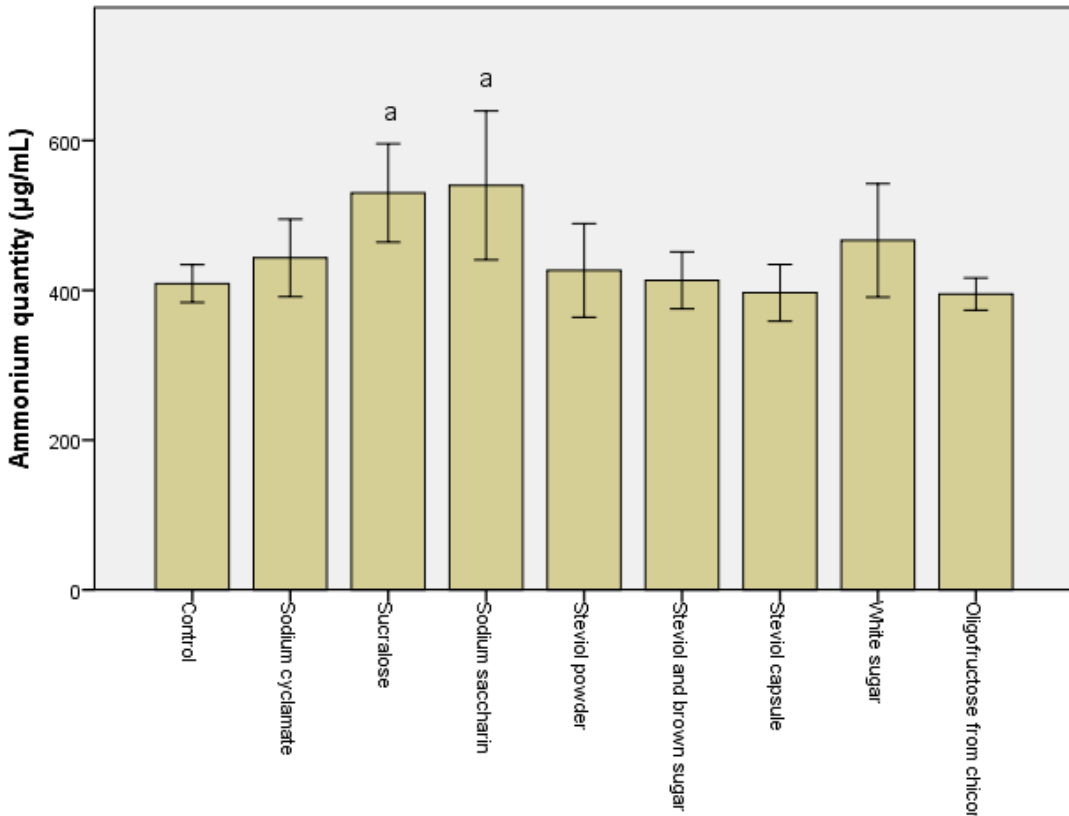
Figure 1. Quantity of ammonium ( µ g / mL) obtained after the in vitro tests through GIS1 as a measure of the impact of consuming sweeteners on the metabolic activity of the microbiota. Different letters indicate significant statistical differences (a: p ≤ 0.05; b: p ≤ 0.01; c: p ≤ 0.001), n = 3.